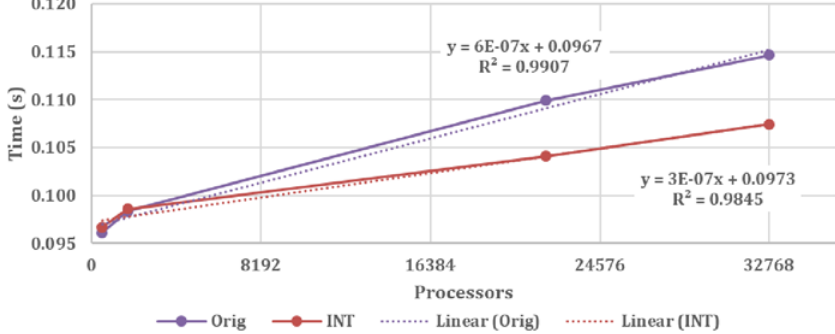
Figure 7: Iteration Time Growth Rate for R/B-4 Weak Scaling (Test Implementation